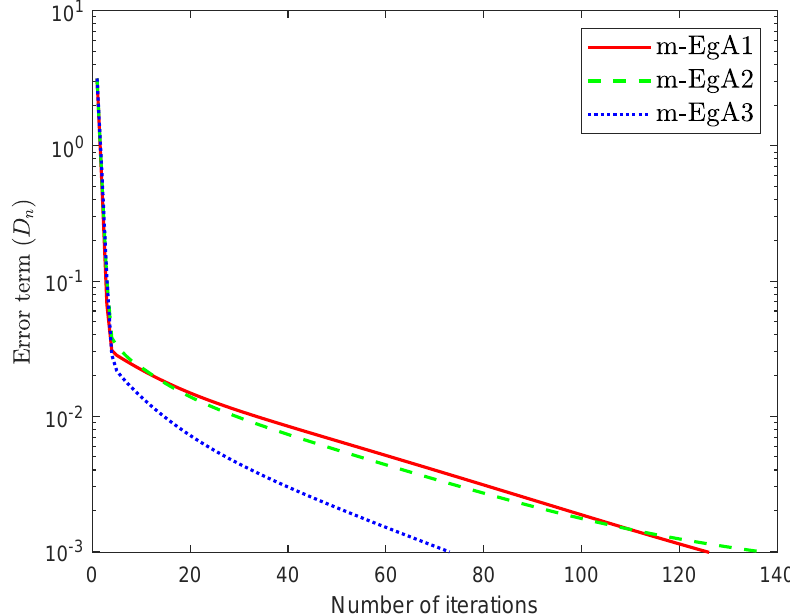
Figure 3. Numerical behaviour of Algorithm 1 compared to Algorithm 1 in [30] and Algorithm 2 in [30] for Example 1, when m = 10.